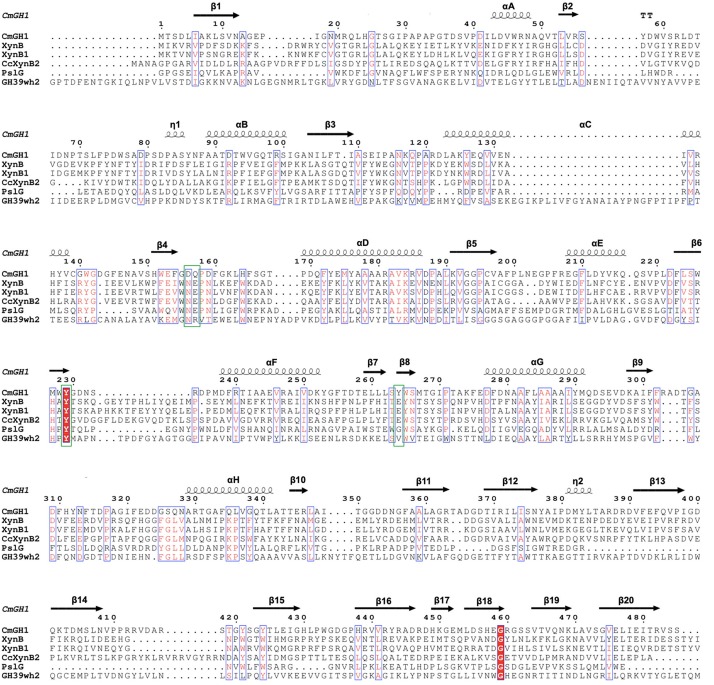
Multiple sequence alignment of CmGH1 with other GH39 family β-xylosidases. The sequences include XynB from T. saccharolyticum [PDB_ID: 1PX8 (Yang et al., 2004)], XynB1 from G. stearothermophilus (PDB_ID: 1W91), CcXynB2 from Caulobacter crescentus [PDB_ID: 4EKJ (Santos et al., 2012)], PslG from P. aeruginosa [PDB_ID: 4ZN2 (Yu et al., 2015)], and GH39wh2 from Bacteroides cellulosilyticus [PDB_ID: 5JVK (Ali-Ahmad et al., 2017)]. Residues that might contribute to catalytic center were labeled by green box.